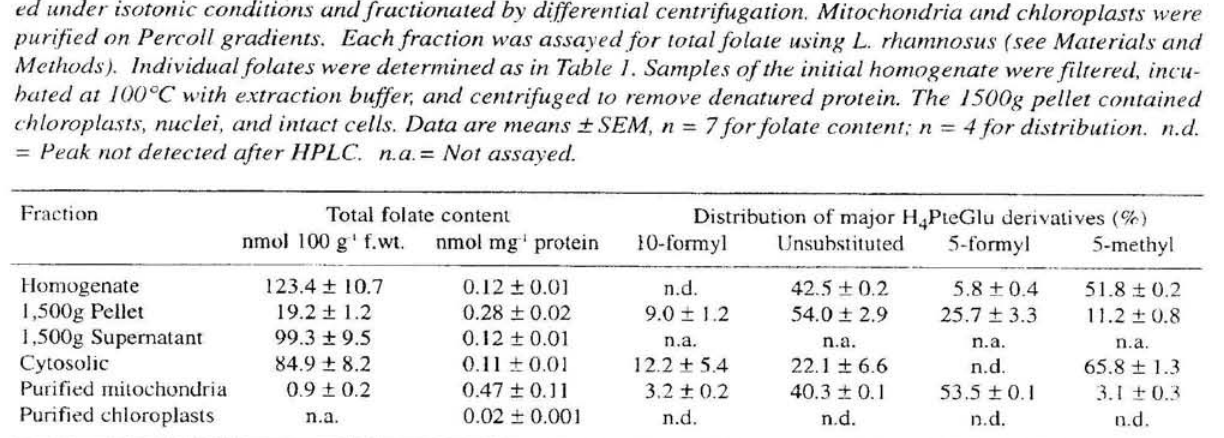
Table 2. The intracellular distribution of folate derivatives in leaves of 14 d pea seedlings. Leaves were extract- by differential centrifugation.